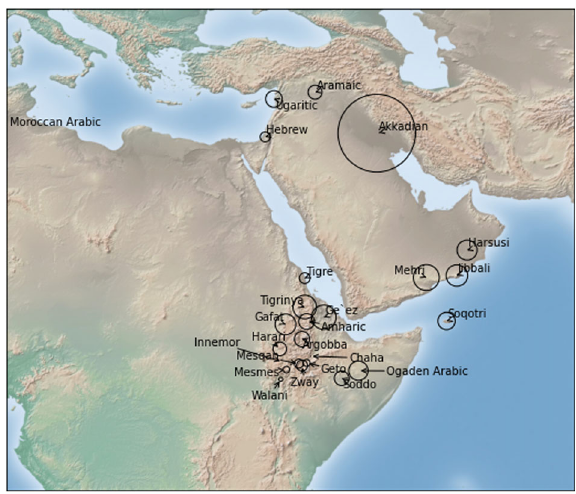
Fig. 9 Geography of the Semitic languages. Circles are proportional to the estimated probability of origin following the tree in Fig.